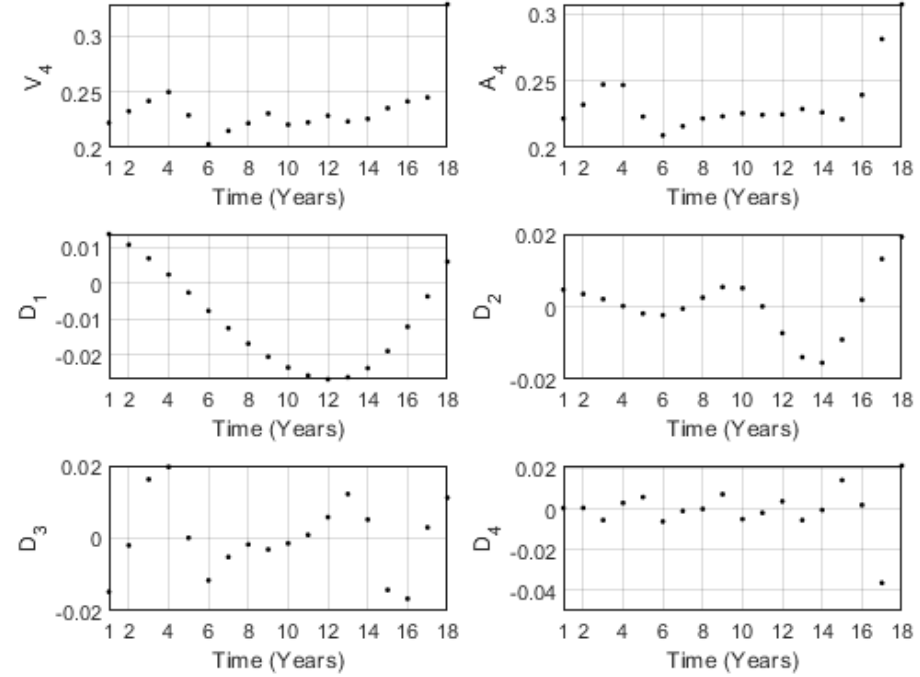
Figure 4. The wavelet decomposition of the variable V 4 at the level 4.